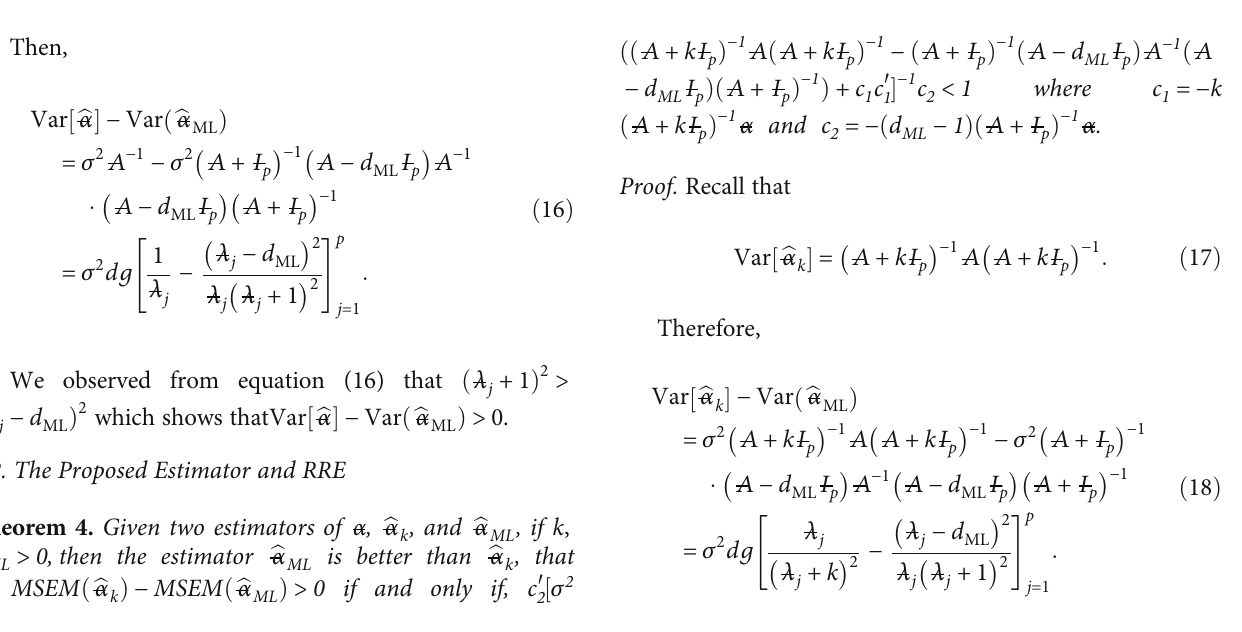
Figure 1: Estimated MSEs for n = 30 . Sigma = 1 , 10; rho = 0 : 70 , 0.80; and di ff erent values of k = d